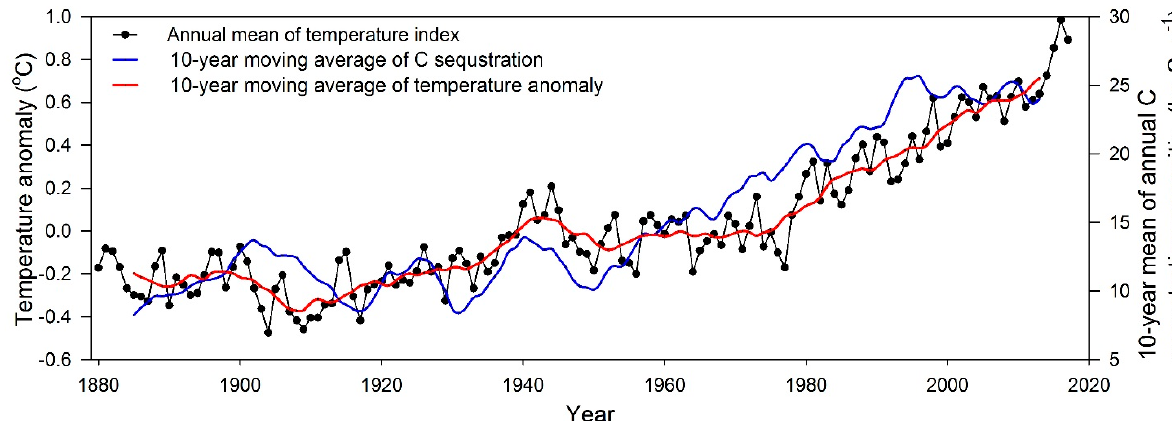
Figure 5. Relationship between global land-ocean temperature index and carbon sequestration capacity in aboveground biomass of P. schrenkiana in the Tianshan Mountains (global annual average temperature anomaly obtained from NASA GISS).